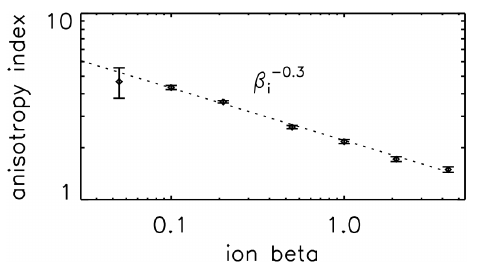
Figure 7. Ion beta dependence of anisotropy index from Fig. 3 and the power-law fitting.